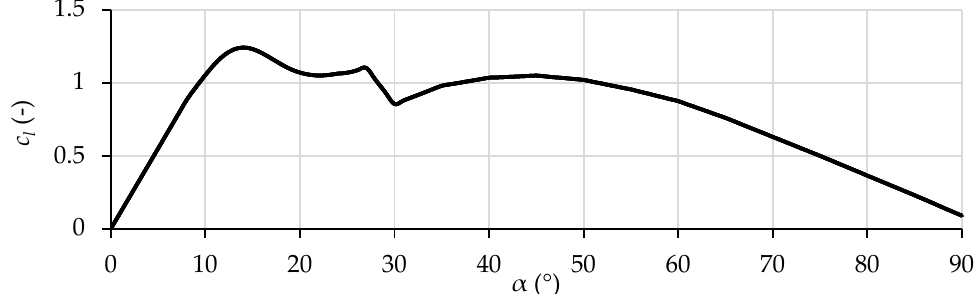
Figure 5. The lift coefficients of the NACA-0015 aerofoil, obtained by iterations of the average Reynolds Number for α < 30 ◦ and independent of the Reynolds Number for α ≥ 30 ◦ .